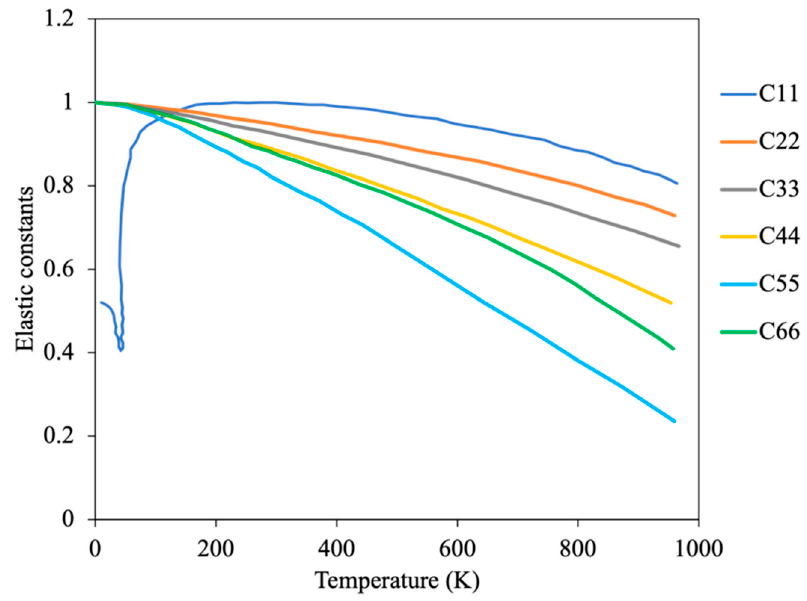
Figure 3. Temperature dependent elastic constants of α -U (Reprinted/adapted with permission from Ref. [23], 2022, Elsevier).